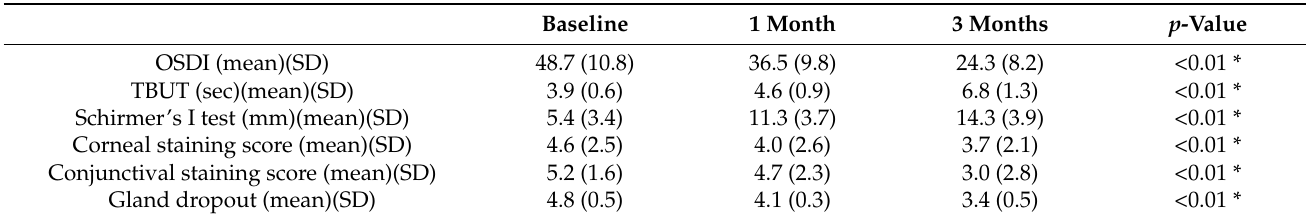
Table 2. Comparison of Parameters on Ocular Surface Disease in Different Time Points.